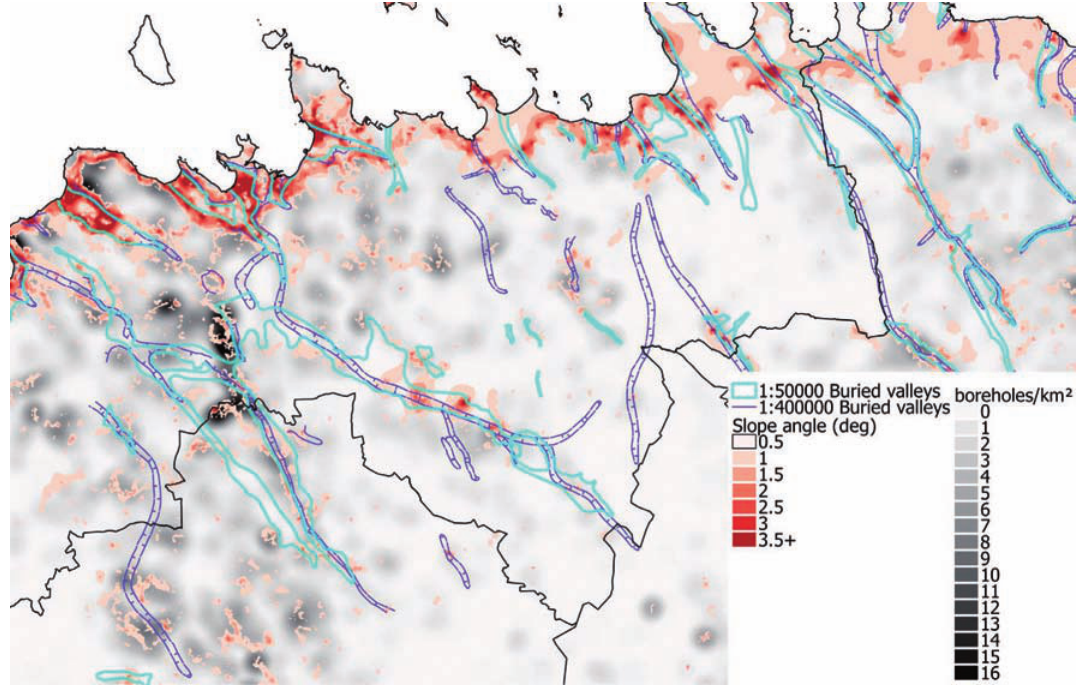
Fig. 9. The rock head elevation (RHE) model of Harju County (area b in Fig. 1). This area has a more varying borehole density and shows good correlation of the slope data with the mapped buried valleys only in the areas with high borehole density. The extent of some buried valleys gains only partial support from the RHE model and the continuity of some valleys can be